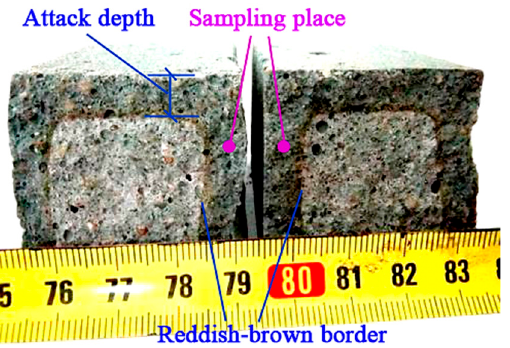
Figure 2. Eroded specimens taken from approximately 2 to 5 mm in depth, apart from the surface.